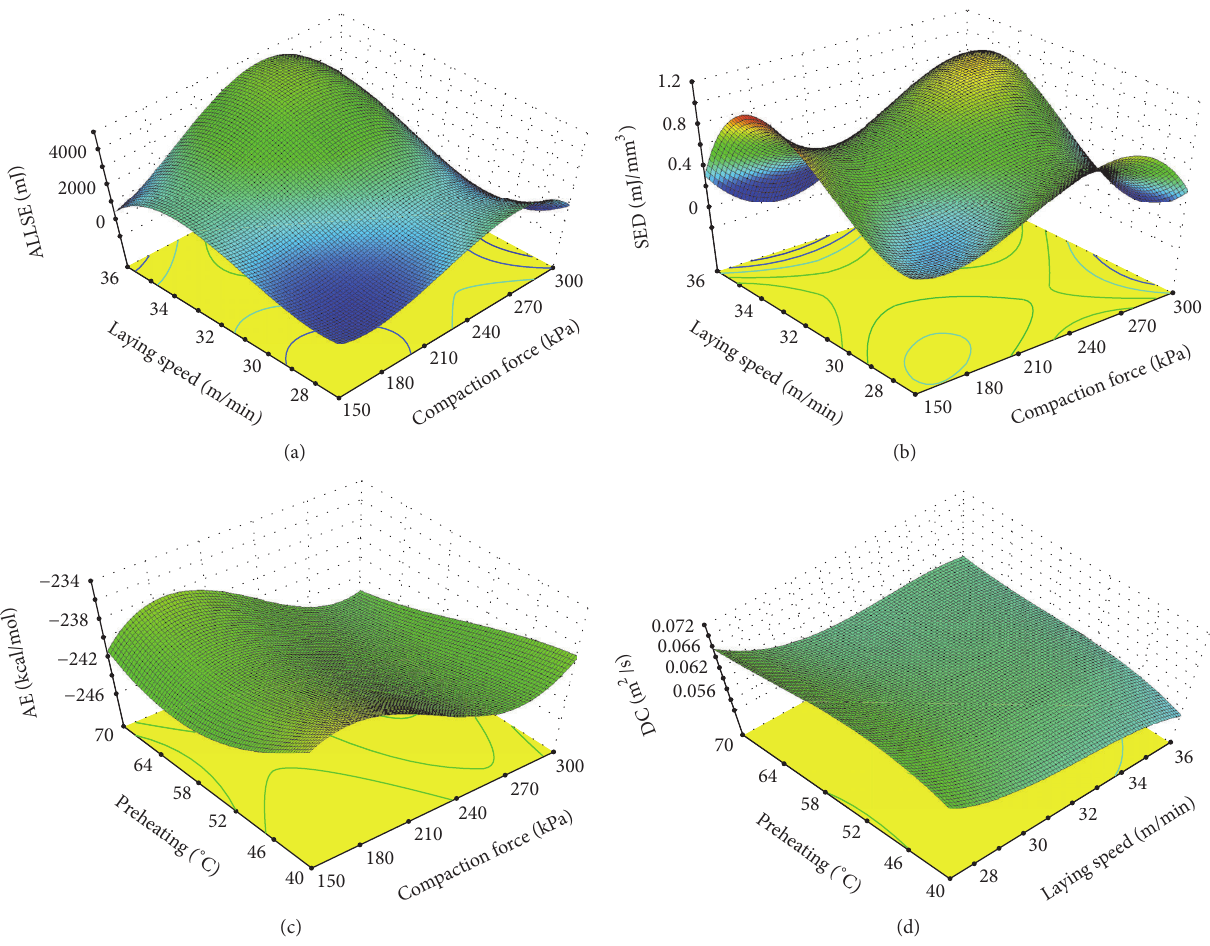
Figure 13: The response surfaces of multiscale variables to processing parameters: (a) the response surface of ALLSE to laying speed and compaction force; (b) the response surface of SED to laying speed and compaction force; (c) the response surface of AE to preheating temperature and compaction force; (d) the response surface of preheating temperature and laying speed.